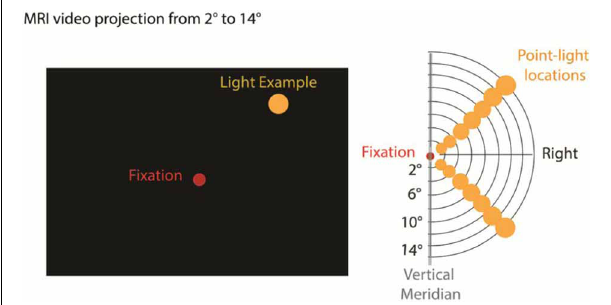
FIGURE 1 | Stimulus presentation and Apparatus. We used a standard MRI video projection system, back projected to a screen viewed by the participants through a monitor. A red fixation point was displayed continuously at center and single point yellow light stimuli were presented in the upper or lower right visual field at polar eccentricities ranging from 2 to 15 ◦ . Standard stimuli (85%) were flashed at 8Hz and target stimuli requiring a button press (15%) were flashed at